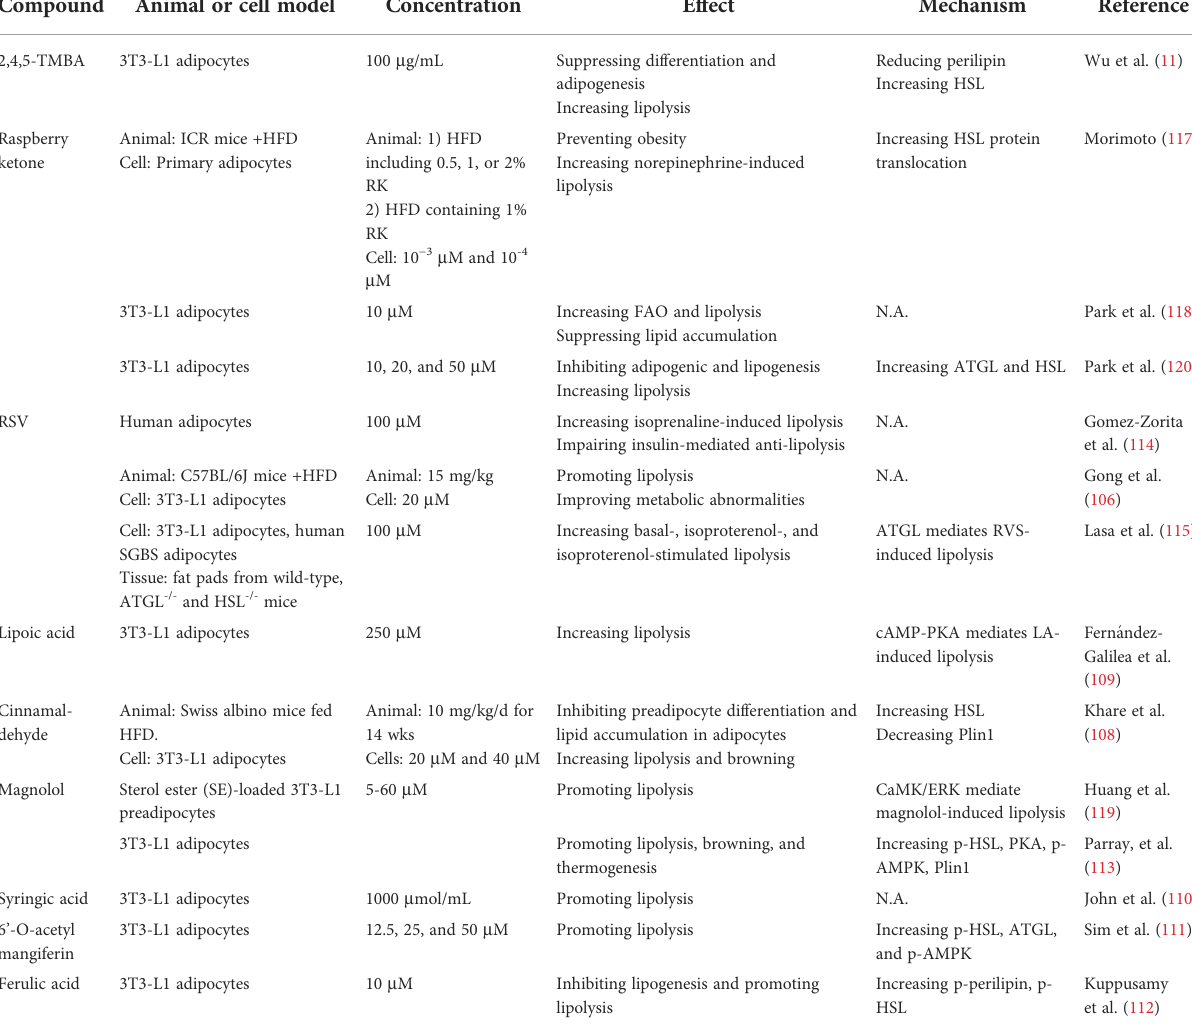
TABLE 4 Lipolytic effects and modes of action of other compounds.